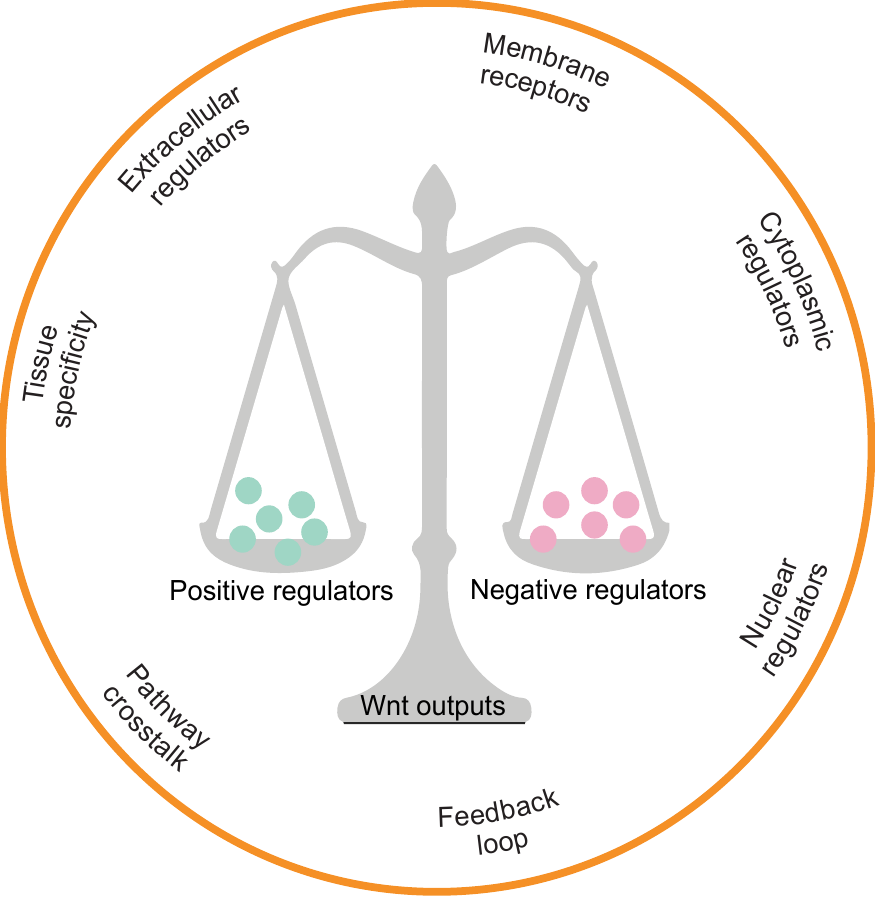
Figure 2. Multidimensional regulators in the Wnt signalling pathway. The hallmark determinants of β -catenin transcriptional output are